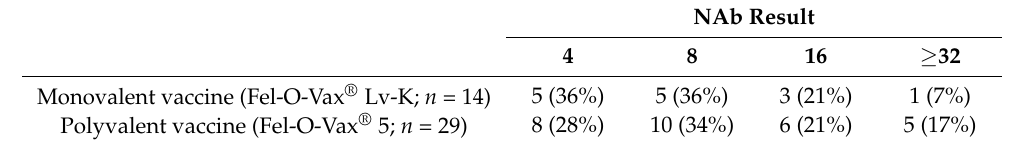
Table 2. Summary of NAb results in vaccinated/exposed cats (abortive infections), arranged by vaccination type and reciprocal titre. A NAb titre of 4 was considered weakly NAb-positive while a NAb titre of 32 or greater was considered strongly NAb-positive. Cats overdue for vaccination were included (one vaccinated with Fel-O-Vax ® Lv-K, three vaccinated with Fel-O-Vax ® 5). NAb = neu- tralising